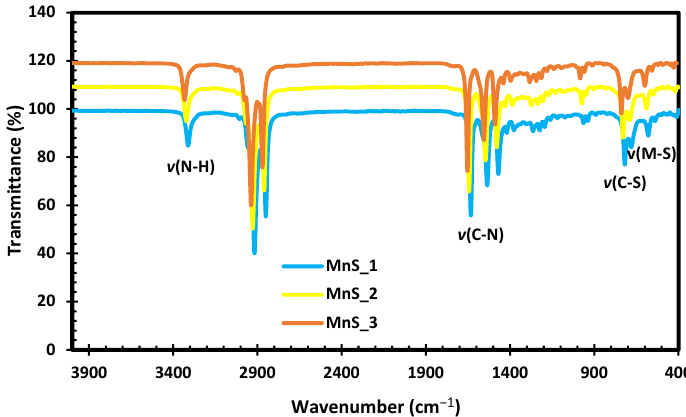
Figure 3. FTIR spectra of MnS_1, MnS_2 and MnS_3 nanoparticles.